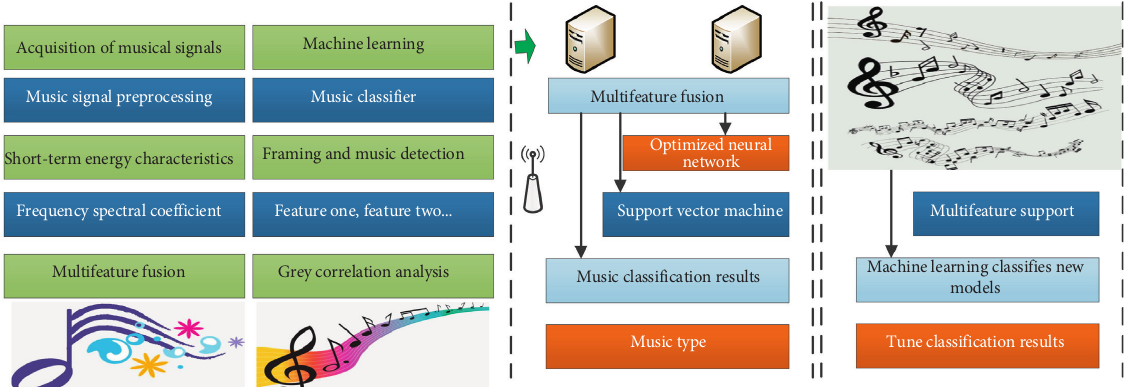
Figure 3: Musical model of multi-feature fusion machine learning.